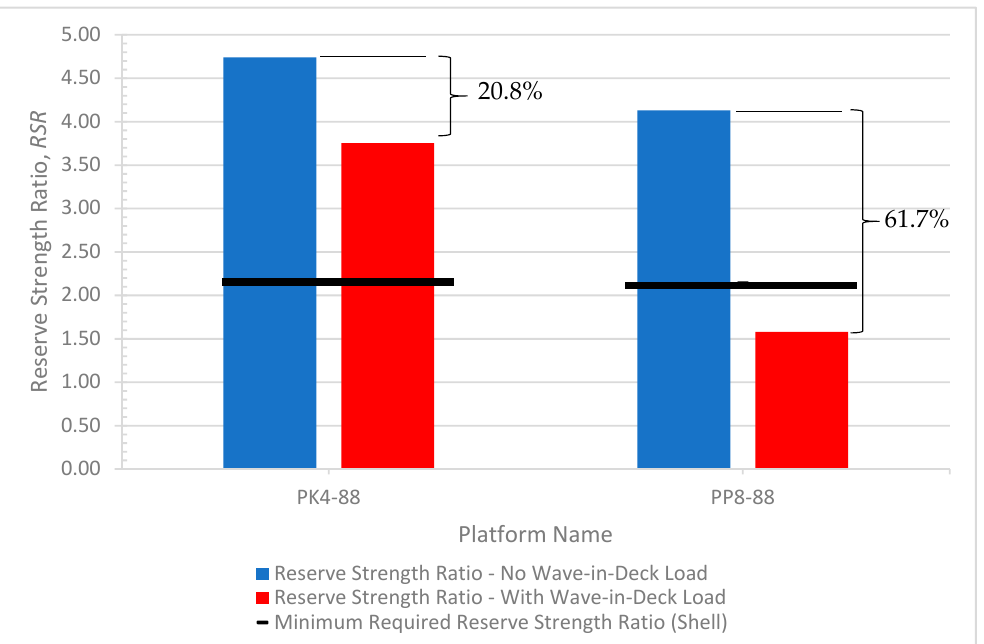
Figure 10. Comparison of reserve strength ratio with and without inclusion of wave-in-deck load.